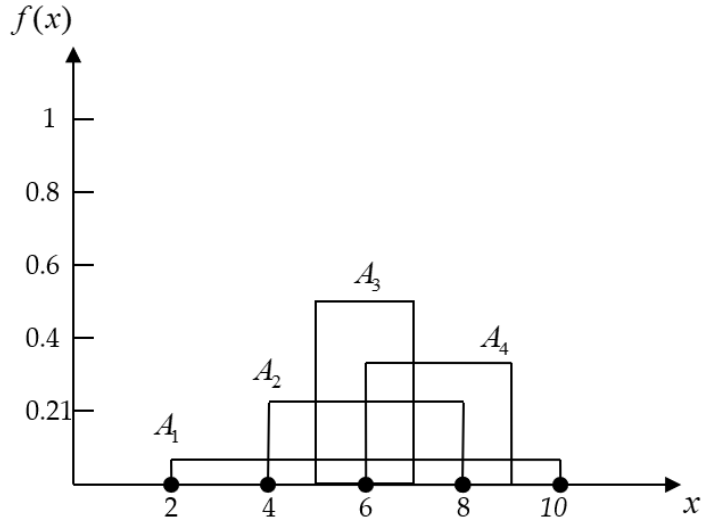
Figure 3. The probability density function in the first example.